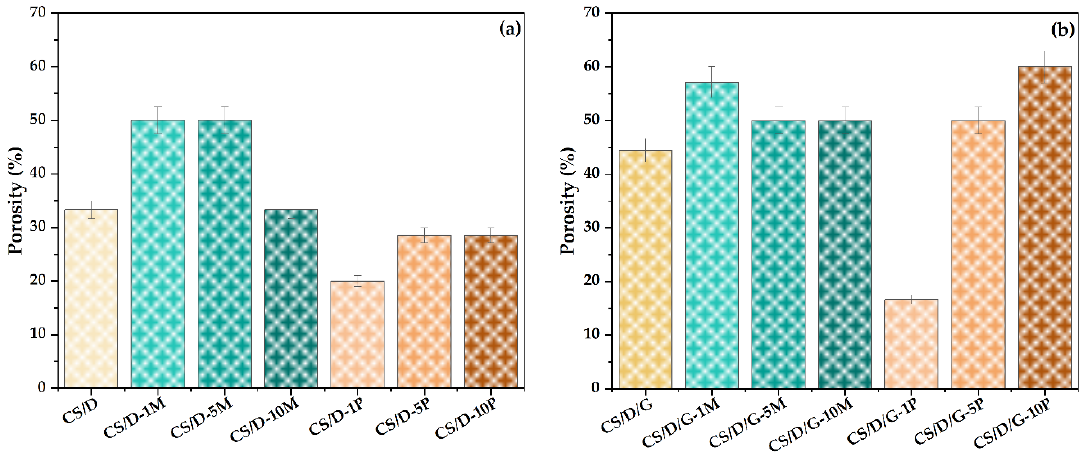
Figure 8. Porosity values for the CS/D ( a ) and CS/D/G hydrogels ( b ).